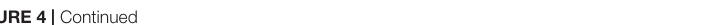
FIGURE 4 | Continued Lower panel: Bars represent densitometric ratios of active Cdc42/total Cdc42 in the lysates. (B) Upper panel: Pak1 activation was tested by immunoprecipitation with anti-Pak and Western blotting with anti-p-Pak1 [Thr (T) 423]. The total amounts of p-Pak1 in the Pak1 IPs were determined by normalizing the amounts to total Pak1 by densitometry. Lower panel: Bars represent densitometric ratios of phospho p-Pak1 (T423)/total Pak1 in the lysates. (C) Upper panel: VICs were either treated with or without 5 µ g/ml of both α 5 and β 1 integrin blocking antibodies for 2 h, or first treated with these blocking antibodies and then transfected with constitutively active (CA) Cdc42 cDNA for 48 h. PAK was immunoprecipitated from these treated/transfected VICs that were stimulated with 1 µ g/ml PN for 5 min at 37 ◦ C, and a nonradioactive kinase assay was done using the traditional in-gel phosphorylation assay. For details of this experiment, see the “Materials and Methods” section. Pak1 kinase activities were evaluated by phosphorylation of substrate MBP (pMBP). The amounts of immunoprecipitated PAK were controlled by anti-PAK1 immunoblotting. Isotype control IgG was used as control. Lower panel: Bars represent densitometric ratios of active Cdc42/total Cdc42 in the lysates. (D) Upper panel: VICs were transfected with indicated lentivirus-expressing vectors. After 72 h, they were treated with and without PN for the indicated times. PAK was immunoprecipitated from platelets stimulated at indicated times at 37 ◦ C and incubated with 1 µ g of MBP in the presence of 20 µ M MgCl 2 -ATP and 0.185 MBq (5 µ Ci) γ [32P]-ATP (for details, see the “Materials and Methods” section). Autophosphorylated PAK was visualized as a 65-kDa phosphoprotein, and its kinase activity was evaluated by phosphorylation of MBP (pMBP). The amount of immunoprecipitated PAK was controlled by anti-PAK1 immunoblotting. Isotype control IgG was used as experiment control. Lower panel: PAK activation from the experiment of (D) was evaluated as in vitro kinase activity toward MBP, and quantification of PAK activity was done by densitometry analysis on ratio of expression of pMBP and total Pak1. (E) In vitro Pak1 kinase assays were further confirmed by nonradioactive assay kit (ab138879, Abcam), which is based on the monitoring of ADP formation (see “Materials and Methods” section for details). Data are presented as fold increase in Pak1 kinase activity with respect to control. (F,G) The effects of dominant negative mutants of N17 Cdc42 (DN Cdc42) and D57Y Cdc42 as well as the impact of blocking antibody for α 5 and β 1 integrin on actin dynamics were assayed. VICs were transfected with the indicated